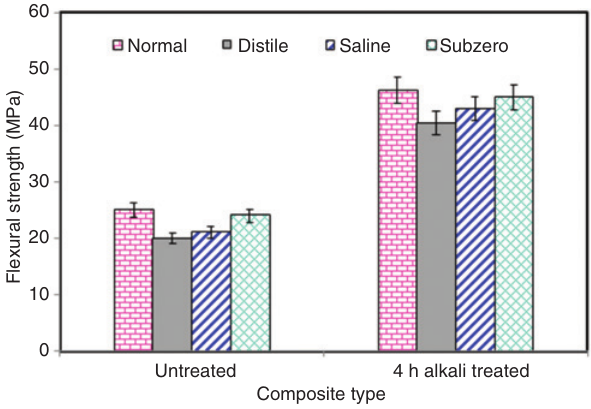
Figure 6: Comparison of the flexural strength of untreated and 4-h alkali-treated (5% conc.) fiber-reinforced composites under distilled water, saline water, and subzero temperature conditions.